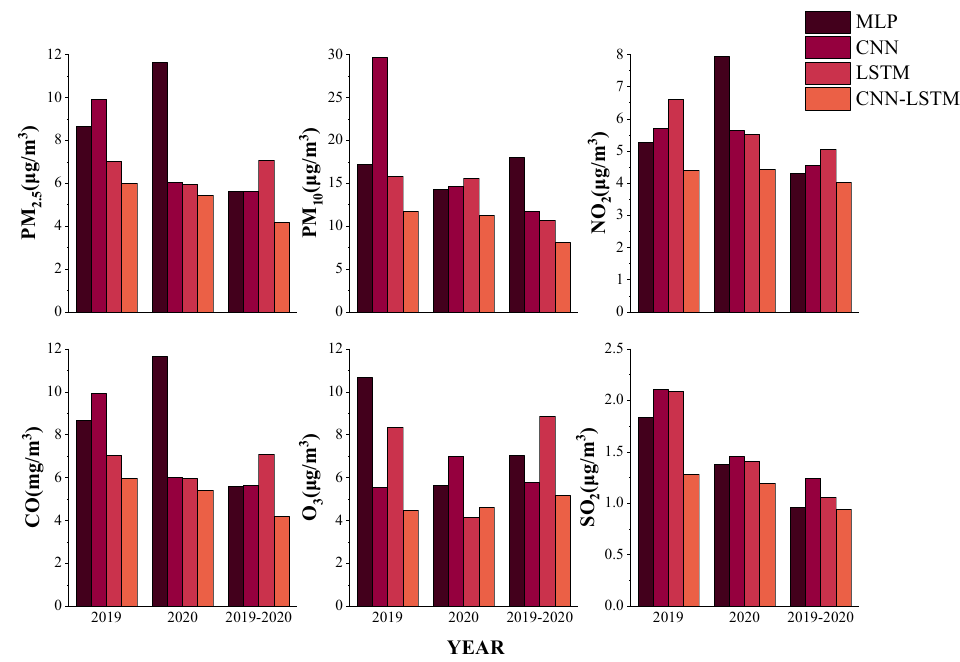
Figure 9. Comparison of RMSE predicted by four models for six air pollutants in 2019, 2020, and